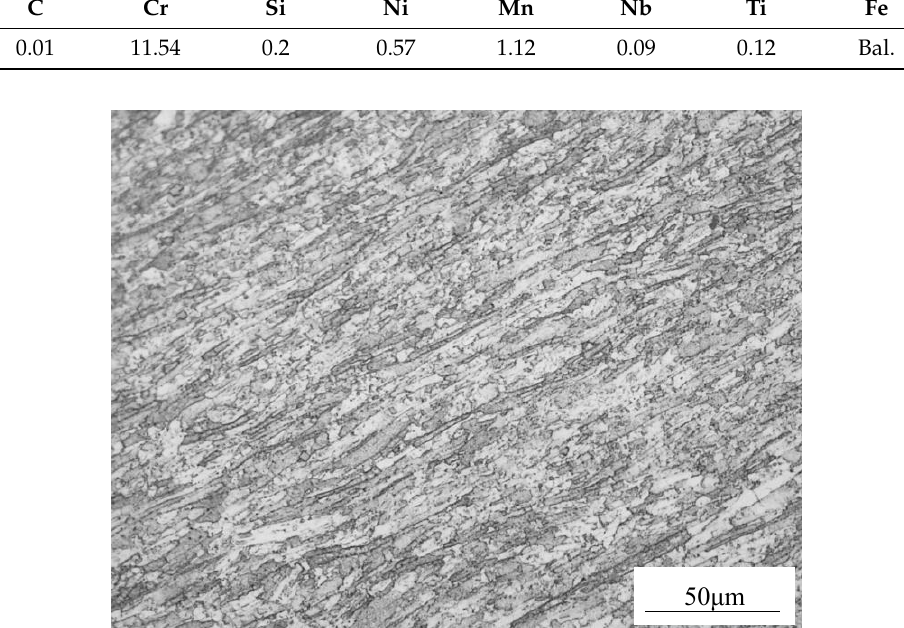
Figure 1. The original microstructure of the employed low-carbon ferritic stainless steel.